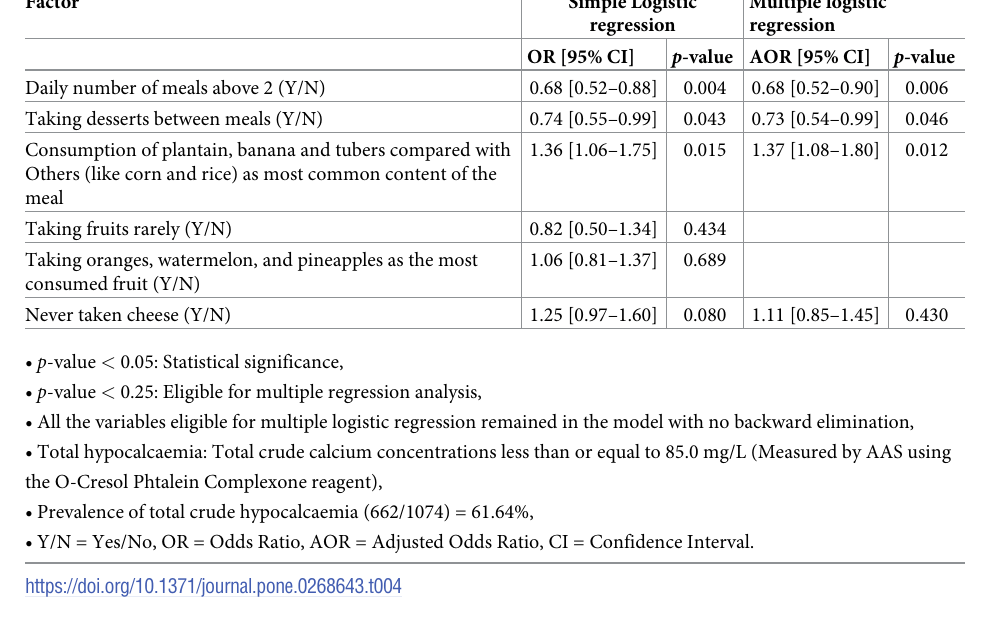
Table 4. Nutritional factors associated with total crude hypocalcaemia.